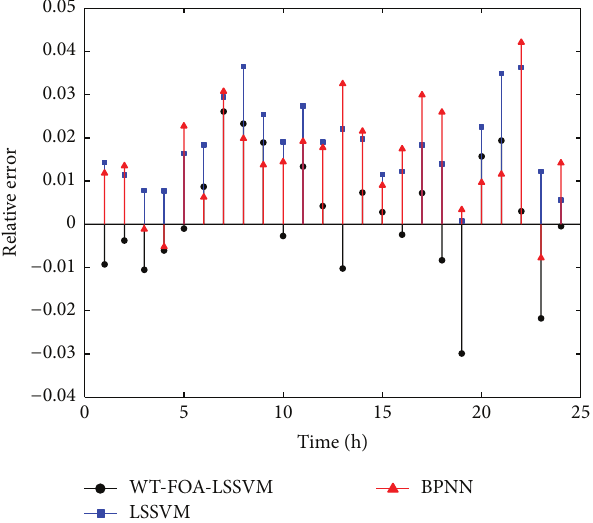
Figure 9: Relative errors of WT-FOA-LSSVM and WT-LSSVM.